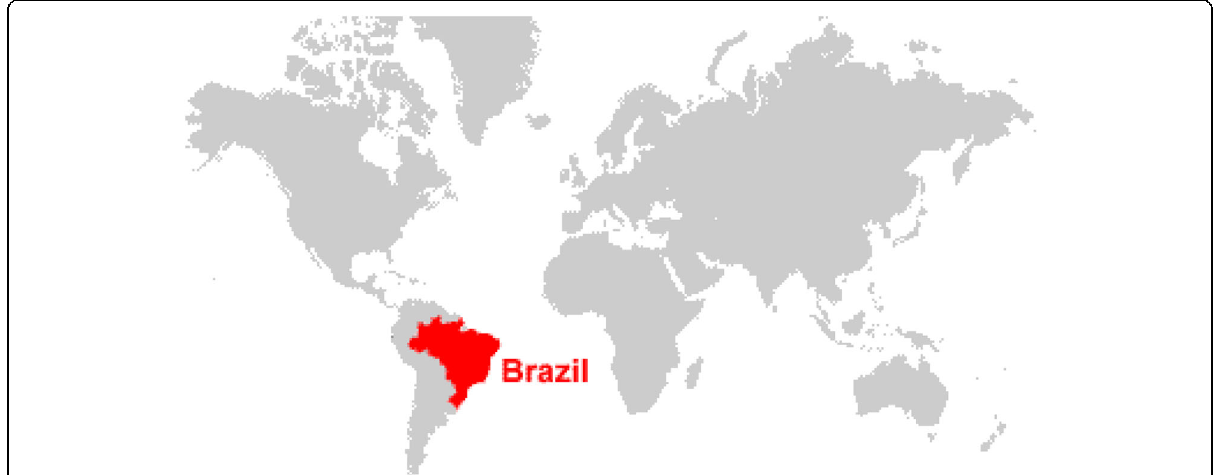
Fig. 1 Location of Brazil. https://wiredre.com/wp-content/themes/new042911/images/brazil-map.gif